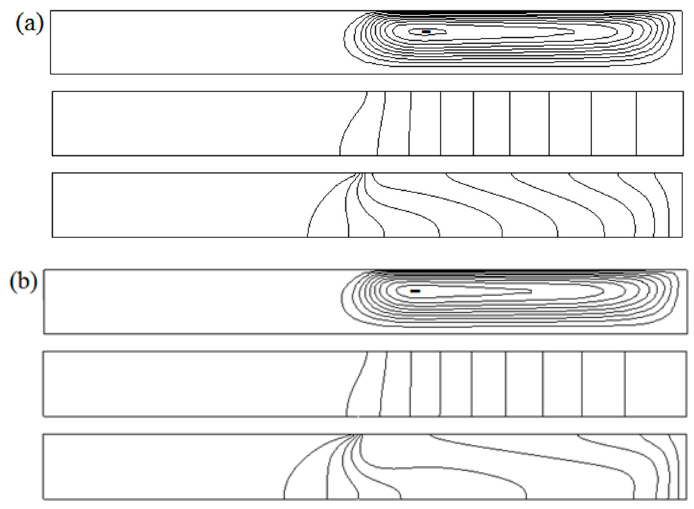
Figure 3. Stream lines, isotherms and iso-concentration lines in the meridional plane at θ = 0 for the basic thermal-solutal flow without rotation. ( a ) Re T = 400, Ψ max( − ) = 0.18; ( b ) Re T = 800, Ψ max( − ) = 0.37.